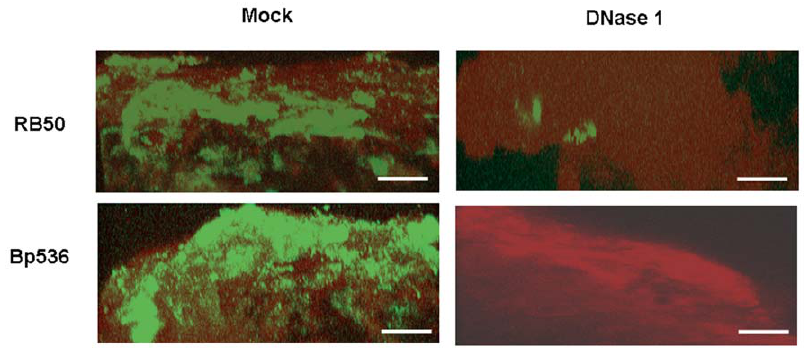
Figure 6. DNase I disrupts established biofilms of B.bronchiseptica and B.pertussis formed in the mouse respiratory tract. CLSM images of biofilms harvested from mouse nose 15 and 19 days postinoculation with RB50 (top) or Bp536 (bottom), respectively. The harvested nasal septum was excised into two equal parts and incubated either with DNase I buffer (Mock, left panels) or with DNase I (right panels) before processing for staining as described in the Materials and Methods. Green staining depicts Bordetella biofilms formed on top of the host epithelium, which is stained red.